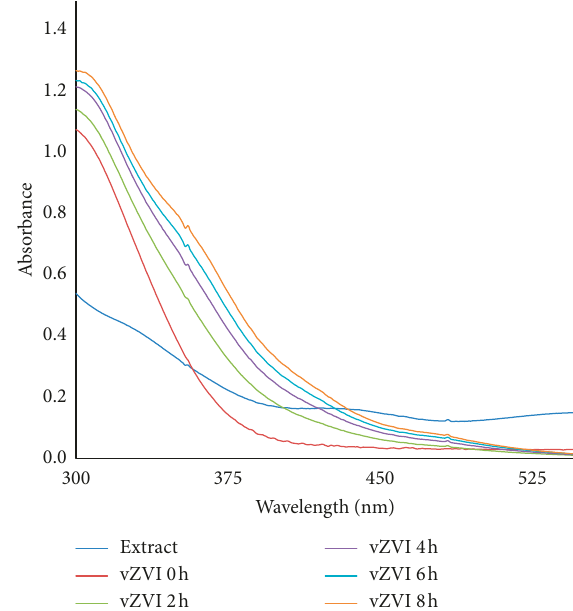
Figure 1: UV spectra of extract ( V. floribundum ) and